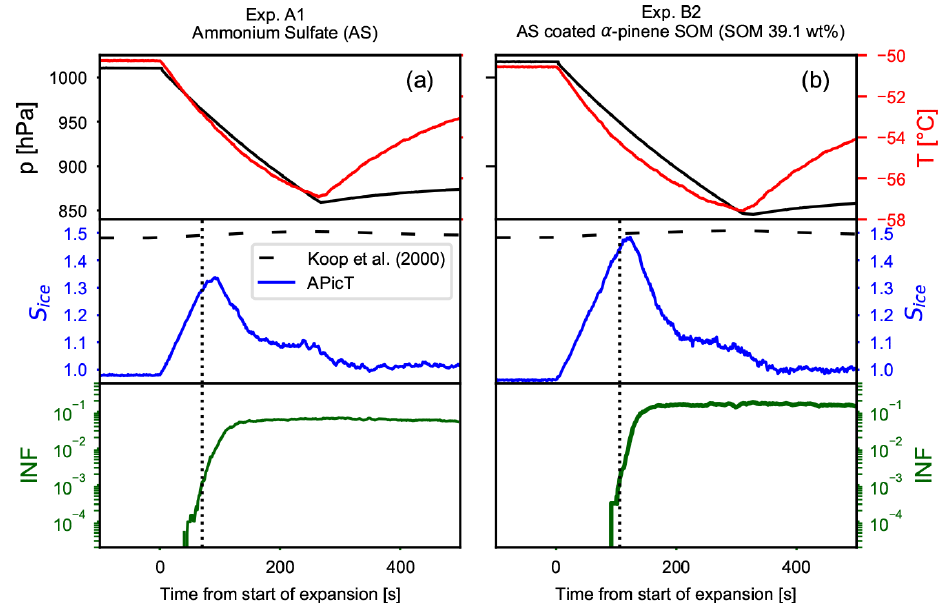
Figure 4. Time series of the AIDA expansion cooling experiments for (a) pure crystalline ammonium sulfate (experiment A1) and (b) am- monium sulfate crystals coated with SOM from the ozonolysis of α -pinene (experiment B2). The upper panels show pressure (black lines, left axis) and temperature (red lines, right axis). The middle panels show the increase in the saturation ratio with respect to ice (blue line). The homogeneous freezing threshold computed for a (cid:49)a w of 0 . 3 of the ice-melting curve (Koop et al., 2000) is indicated with the horizontal dashed lines. The lower panels show the fraction of aerosol particles that induced ice formation (ice-nucleating fraction, INF). The vertical dotted lines indicate when 0.1% of the aerosol particles acted as